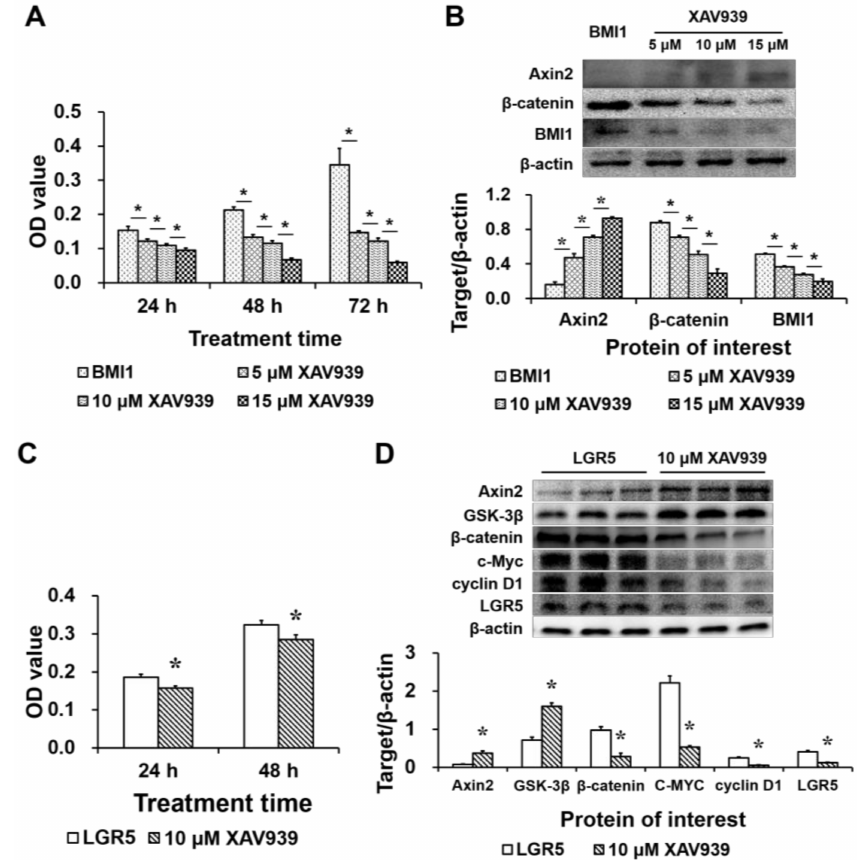
Figure 7. The effects of XAV939 supplementation on cell proliferation and protein expression in LGR5 -overexpressing or BMI1 -overexpressing IPEC-J2 cells. ( A ) The OD values were lower in the 5-, 10- or 15- µ mol/L XAV939 groups than in the BMI1 -overexpressing group at 24, 48 and 72 h after treatment, as assessed by the MTT assay ( n = 20); ( B ) The levels of AXIN2, β -catenin and BMI1 were assessed by Western blot ( n = 3); ( C ) The OD value was lower in the 10- µ mol/L XAV939 group than in the LGR5 -overexpressing group at 24 and 48 h after treatment, as assessed by the MTT assay ( n = 20); and ( D ) The levels of WNT/ β -catenin signaling-related proteins and LGR5 were assessed by Western blot ( n = 3). The results were confirmed by three independent experiments per treatment. Representative results of the three independent experiments are shown. The bars are the means ± SE, * indicates a significant difference ( p <